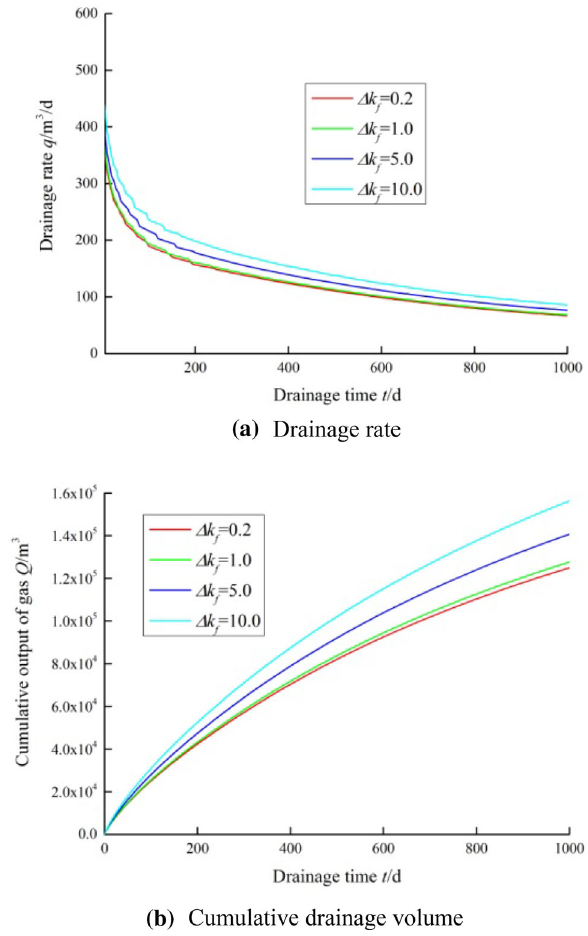
Fig. 11 Output rate and cumulative output of gas in coal seams with different permeability (injection temperature is 90 (cid:3)